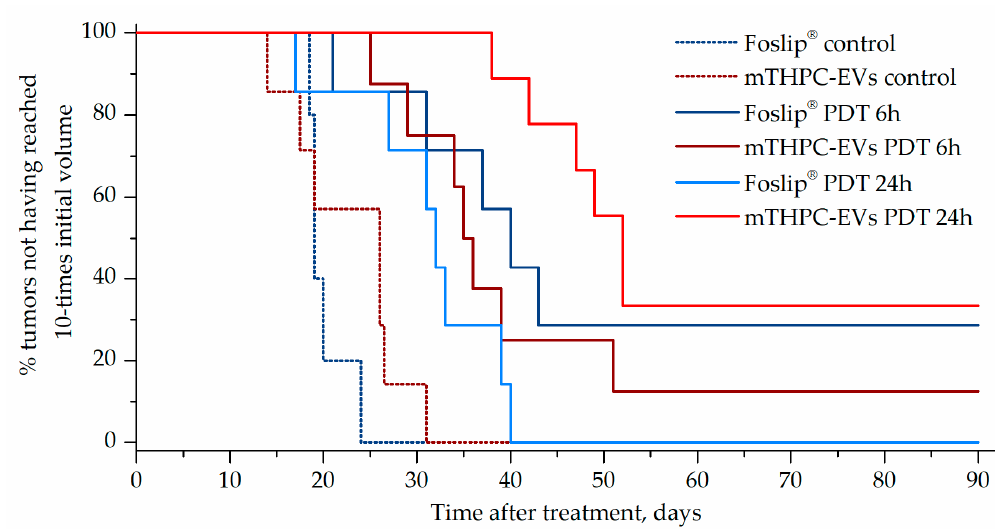
Figure 6. Kaplan–Meier plots of HT-29 tumor growth delay after PDT with Foslip ® and mTHPC-EVs. Cured mice are included and defined as an absence of tumor regrowth after 90 days post-PDT. The tumor growth of control mice is depicted in the dotted line.